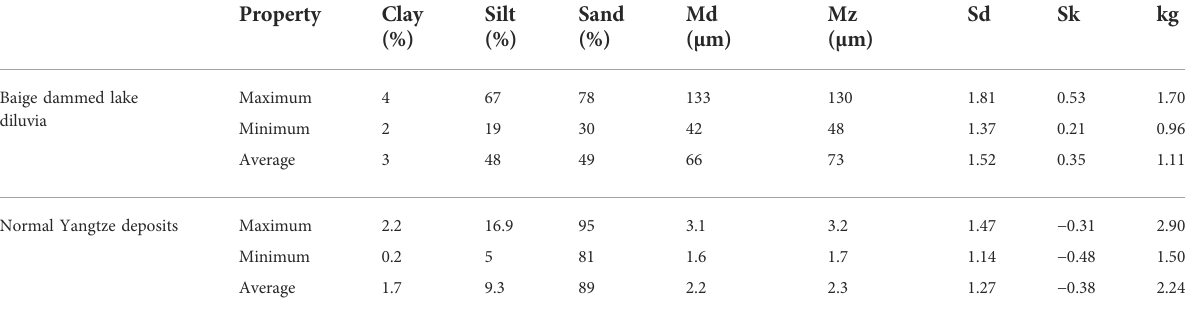
TABLE 2 Grain size parameters of diluvia from the Baige dammed lake and normal Yangtze deposits.